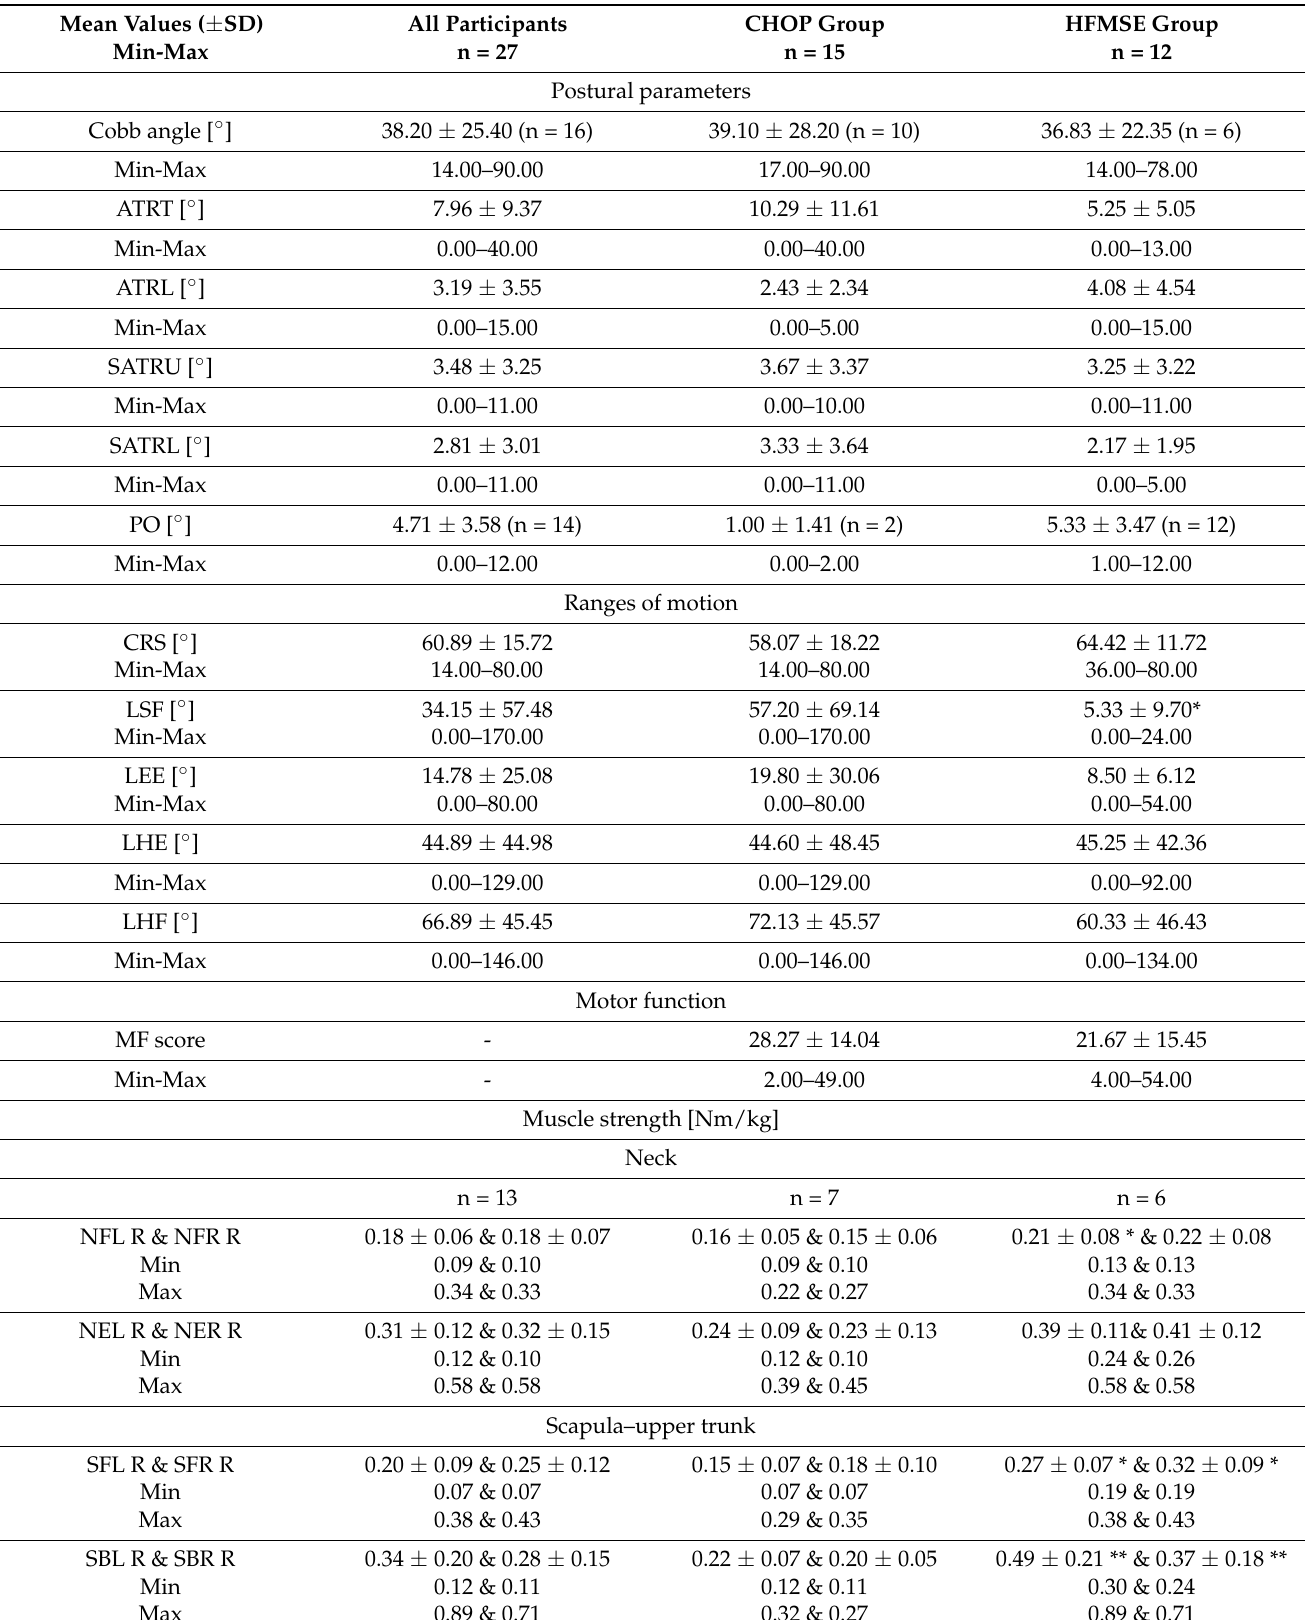
Table 2. Values of the postural parameters, ranges of motion, motor function score, and muscle strength measurements. Mean Values ( ±